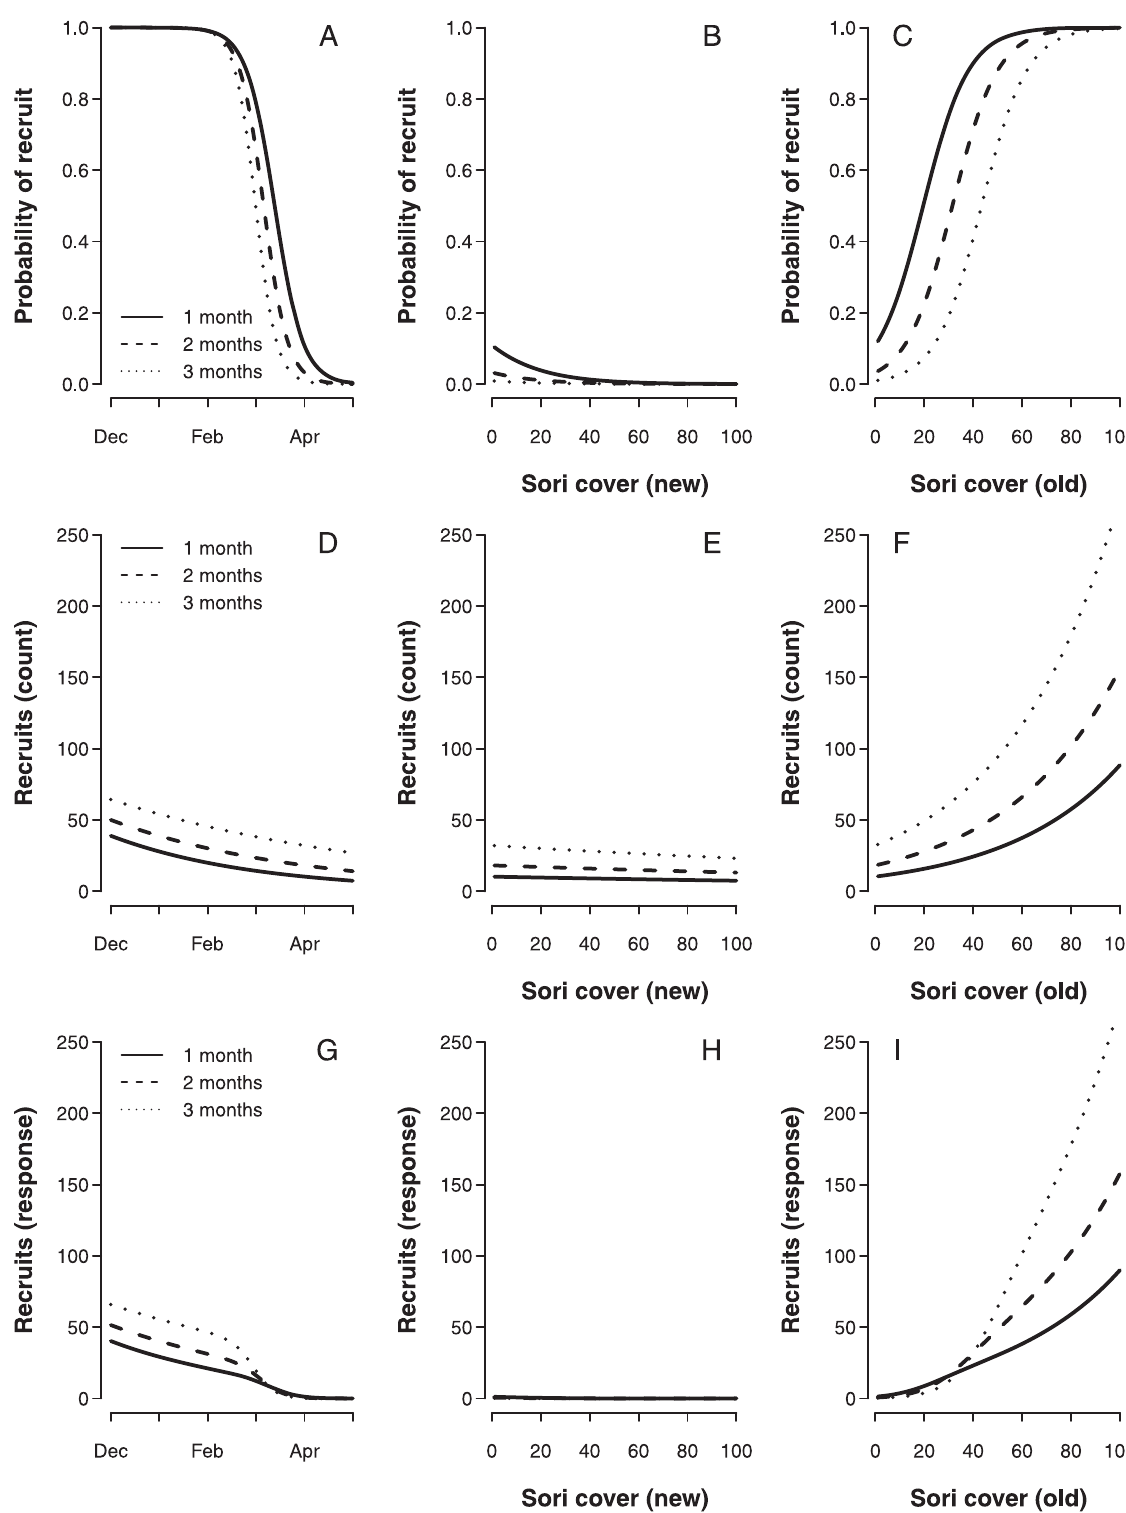
Figure 2. Graphical presentation of the model predictions in relation to varying time of tile deployment, sori cover on new tissue, and sori cover on old tissue. Different line types represent different durations of tile deployment. A, B, and C show the predicted probability of observing recruitment. D, E, and F show the predicted number of recruits where recruits are present, while G, H, and I show overall count predictions.